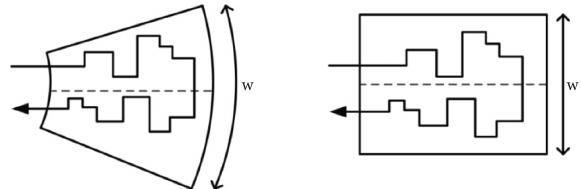
Figure 1: Vehicle routing in a zone with width ( w